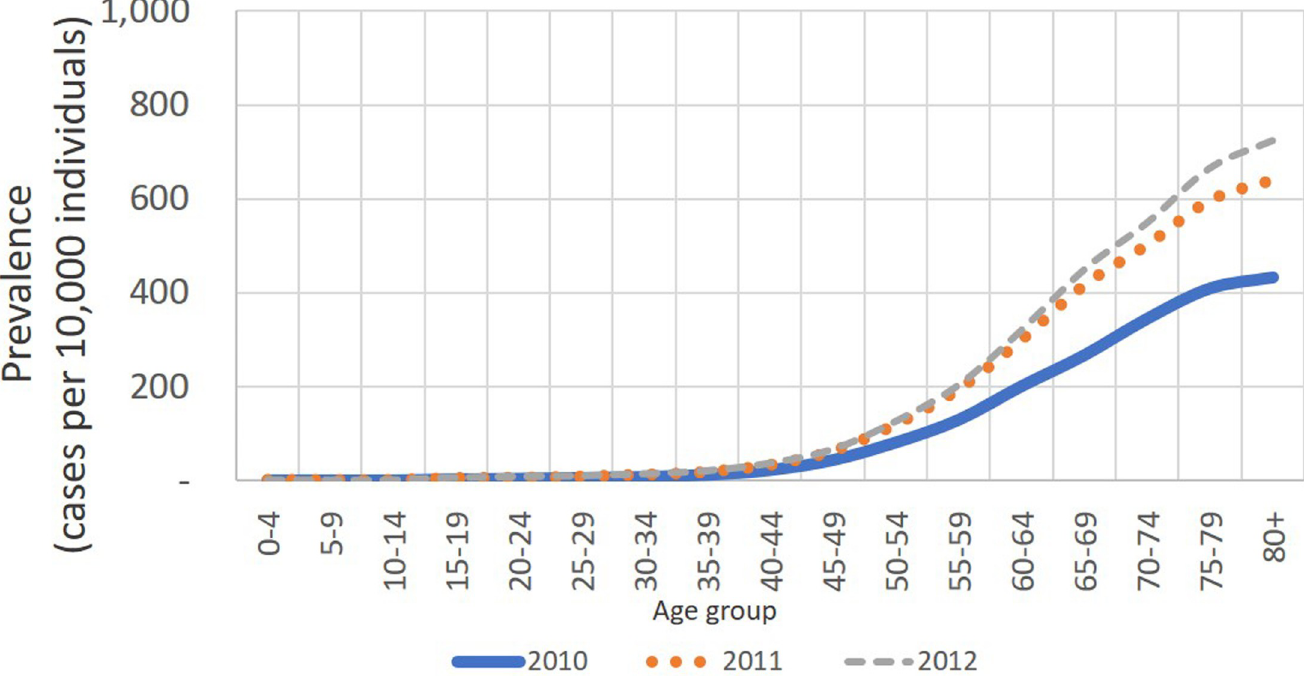
PLOS ONE | https://doi.org/10.1371/journal.pone.0208513 December19,